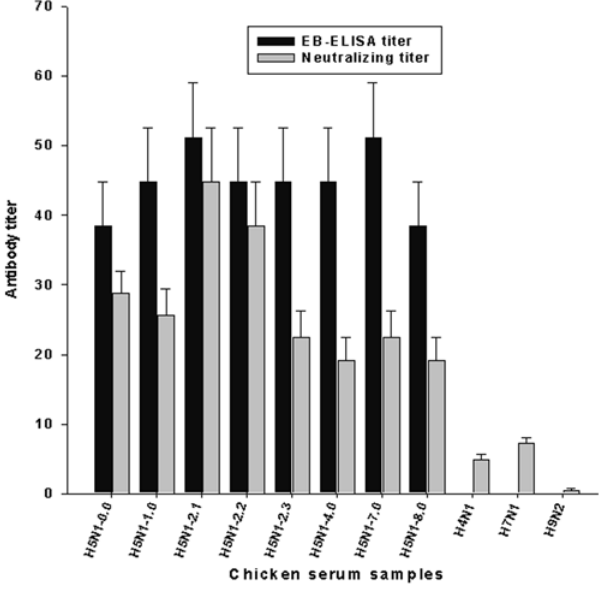
Figure 4. Comparison of EB-ELISA to microneutralization assay. The H5N1 antibody detection sensitivity and specificity of the EB-ELISA and microneutralization assays were compared using immune chicken sera collected 10 days after second immunization (adjusted to HI titer of 16) to determine the endpoint of inhibition. Chicken antisera to clade 0 (A/HK/156/97), 1 (A/Vietnam/1203/04), 2.1 (A/Indonesia/ CDC1031/07), 2.2 (A/turkey/Turkey1/05), 2.3 (A/Anhui/1/05), 4 (A/ Guiyang/337/06), 7 (A/Shanxi/2/06) and 8 (A/chicken/Henan/12/04) as well as H4N1, H7N1 and H9N2 were used. The EB-ELISA titer was determined as described in the Methods section. The neutralization